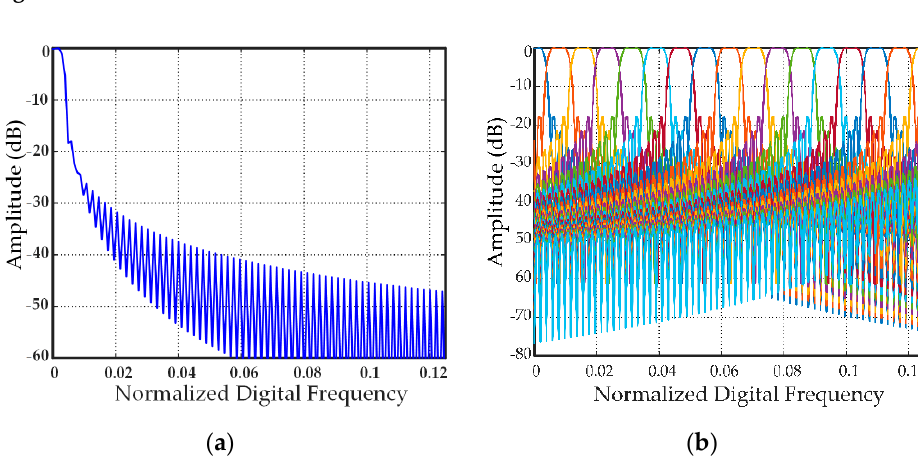
Figure 2. M-channel multi-rate filter bank.